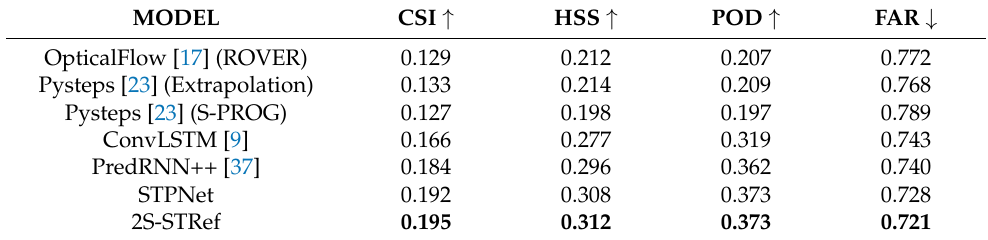
Table 8. Skill score at R > 45 dBZ (two-hour